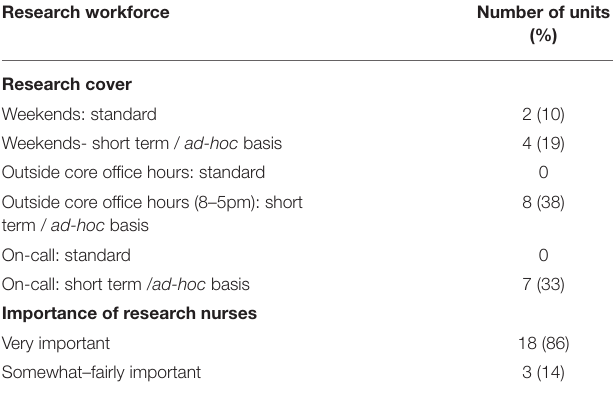
TABLE 2 | Research delivery staffing across UK/ IRL